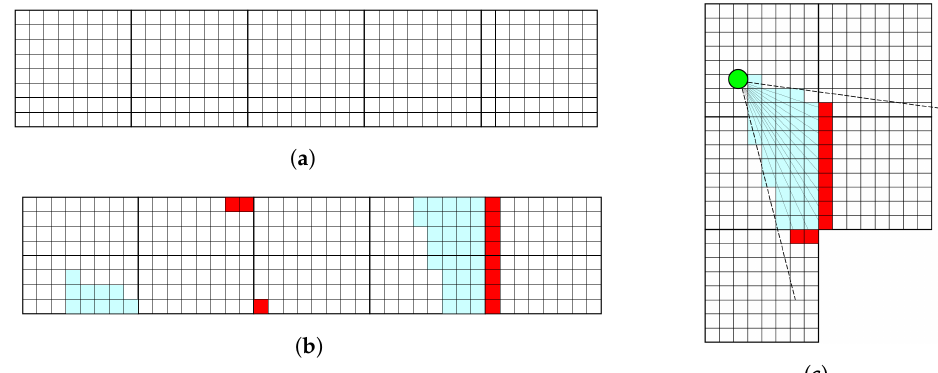
Figure 2. Voxel level ray-casting. ( a ) Voxel-level array allocated or zeroed. ( b ) Voxel array populated with ray-casting results. ( c ) Voxel-level ray-casting